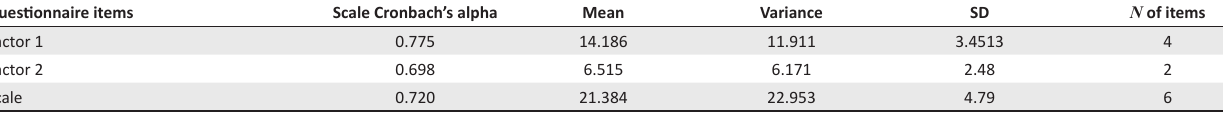
TABLE 5b: Iterative reliability analysis of questionnaire